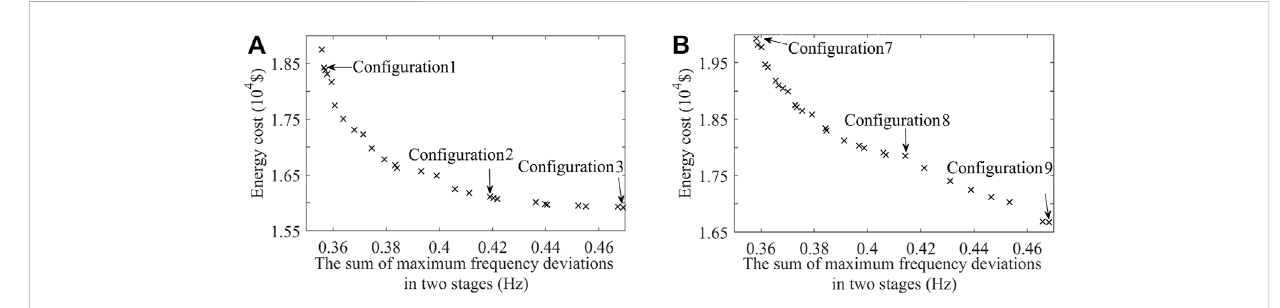
FIGURE 3 Pareto results considering SFD under (A) scenario 1 and (B) scenario